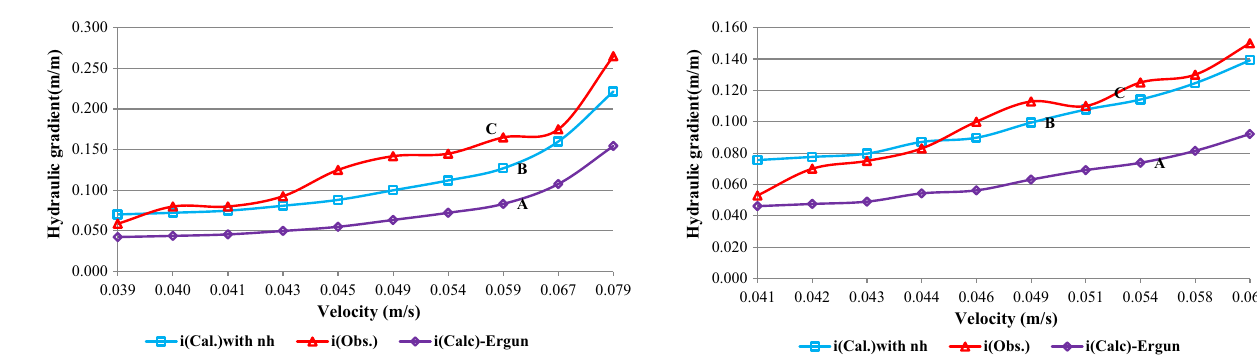
Fig. 14 Comparing plots of hydraulic gradient versus velocity for CGM2 series. Result is after 1200 s of run start. Curve “A” shows variations of ( i ) versus ( V ) based on common porosity concept, curve “B” shows variations of ( i ) versus ( V ) based on hydraulic porosity concept, curve “C” shows variations of ( i ) versus ( V ) based on actual model observations